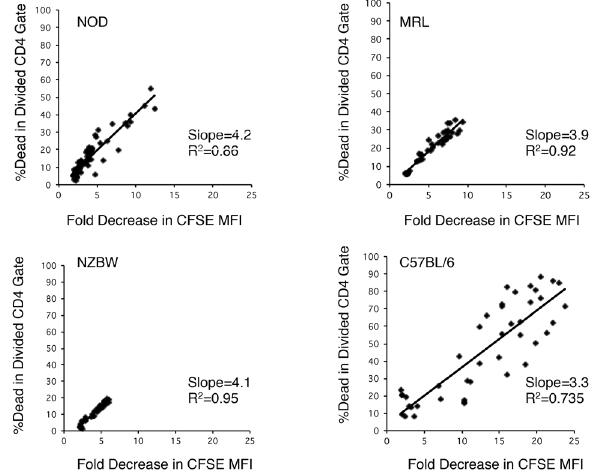
Figure 5. Susceptibility to activation induced cell death is governed by cell divisions. The percentage of cell death as detected by 7-AAD staining in the divided CD4 T cell gate is plotted against the fold reduction in median fluorescence intensity as an indicator of the extent of cell division. Dots from twelve stimulation conditions in four separate experiments are plotted. Stimulated cells from C57BL/6 animals achieve nearly twice the maximal division seen for the autoimmune strains as indicated by the maximum reduction in CFSE intensity and, therefore, they undergo more AICD. However, at shared points along the ordinate, all four strains demonstrate similar levels of cell death.